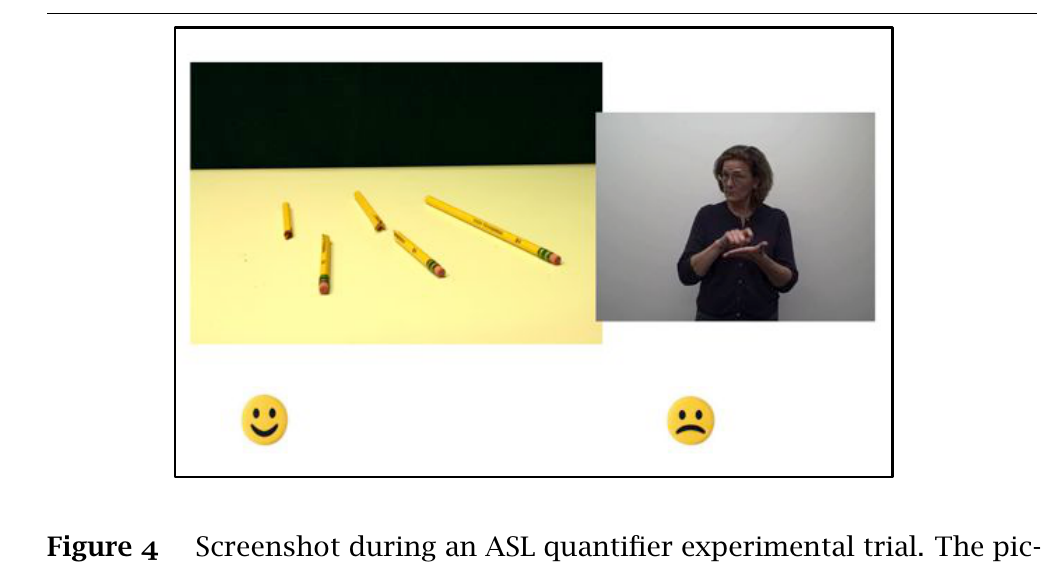
Figure 4 Screenshot during an ASL quantifier experimental trial. The pic- ture is always on the left, and the signed description of the picture appears on the